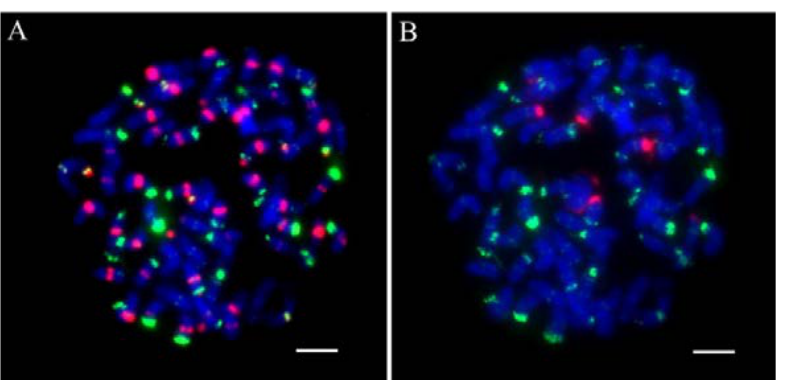
Figure 5. The result of repeat FISH. ( A ): The first round of FISH results; ( B ): The second round of FISH results. Scale bars = 5 μm.